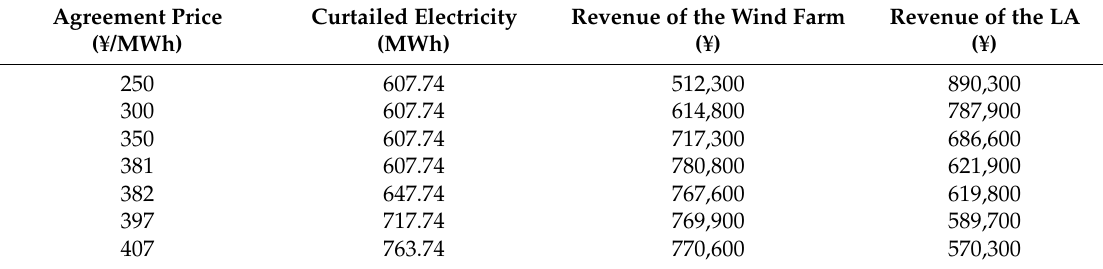
Table A1. Wind curtailment and the revenues of both sides under different agreement